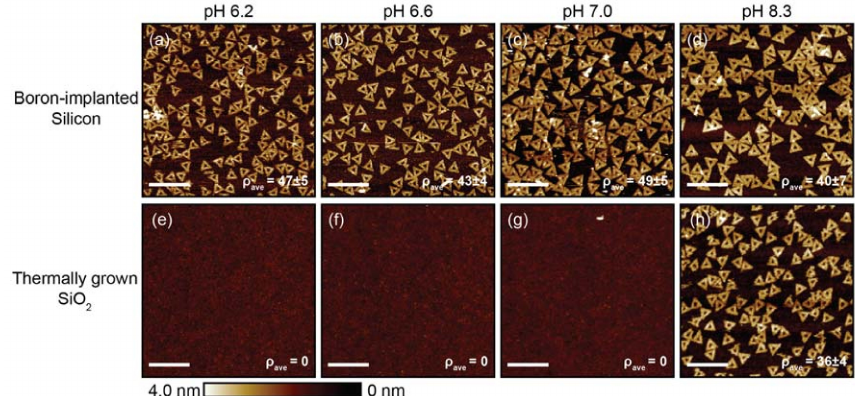
Figure 3. AFM images of DNA origami triangles adsorbed onto boron-implanted silicon substrates ( a – d ) and thermally grown silicon dioxide (SiO 2 ) substrates ( e – h ) as a function of deposition buffer pH. The substrates were cleaned with Piranha + HF. For the pH values below 8.3, the deposition buffer was 10 mM bis-tris HCl with a [MgCl 2 ] of 35 mM. For the pH value of 8.3, 1 × tris-acetate- ethylenediaminetetraacetic acid (EDTA) with a [MgCl 2 ] of 35 mM was selected to stay within the buffer range. For all conditions, the deposition incubation time was ~1 h. Scale bars are 500 nm.